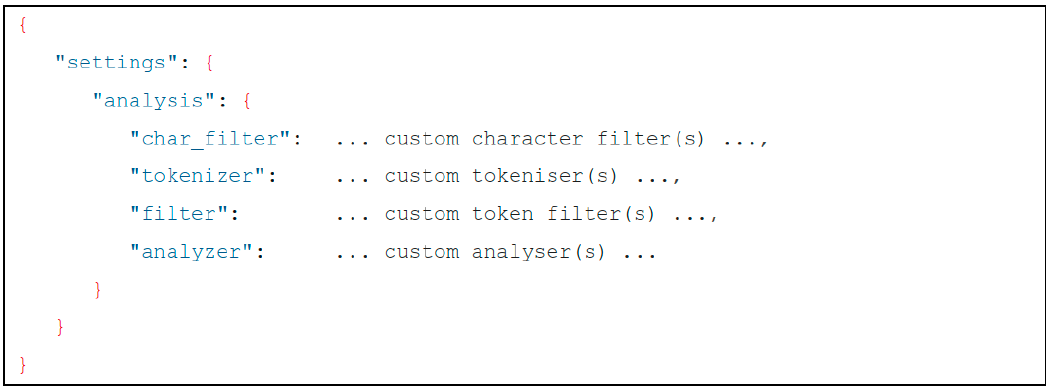
Figure 1. Defining an analyser in Elasticsearch.